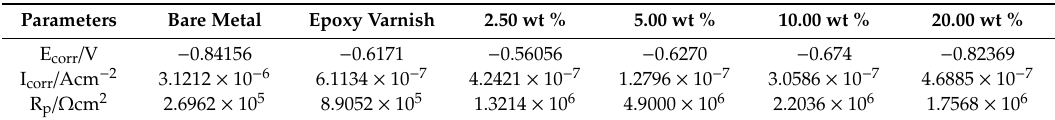
Figure 4. The single-polar, ion-selective coatings and the protective performance. ( a ) and ( b ) are the schematic illustrations of the repulsion function of the cationic coating and anionic coatings. ( c ) and ( d ) are potentiodynamic polarization curves of the cationic and anionic coatings with different doping concentrations of anion and cation exchange resins. Table 1. Fitting results of Q235 steel coated with cationic coatings with different concentrations of anion exchange resin.